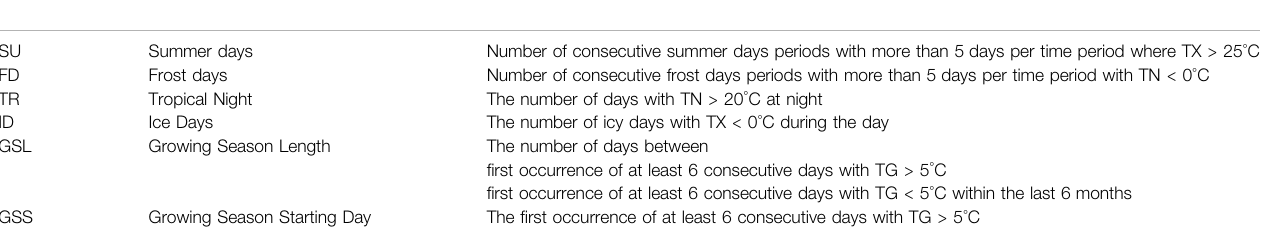
TABLE2| SubsetofthestandardETCCIindices,theirabbreviations,andtheirdescriptions.Theclimateindicesarecalculatedforeach experimentdescribedin Table1 .TX is daily maximum temperature, TN is daily minimum temperature and TG is daily mean temperature.